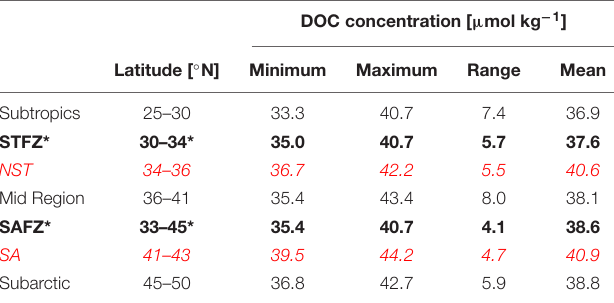
*The latitudes are shifted to exclude the embedded Northern Subtropical Front (NST) and Subarctic Front (SA) within the Subtropical Frontal Zone (STFZ) and Subarctic Frontal Zone (SAFZ), respectively. Individual fronts are shown in red. The bold and italics in this table correspond to the previously defined identification